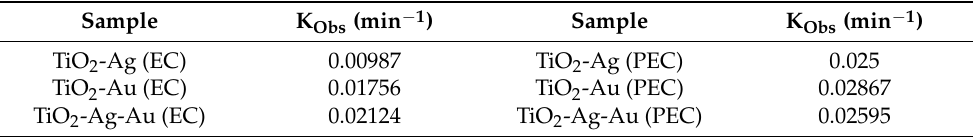
Table 1. Rate constant (K Obs ) values for the different photoanodes applied to EC and PEC processes.